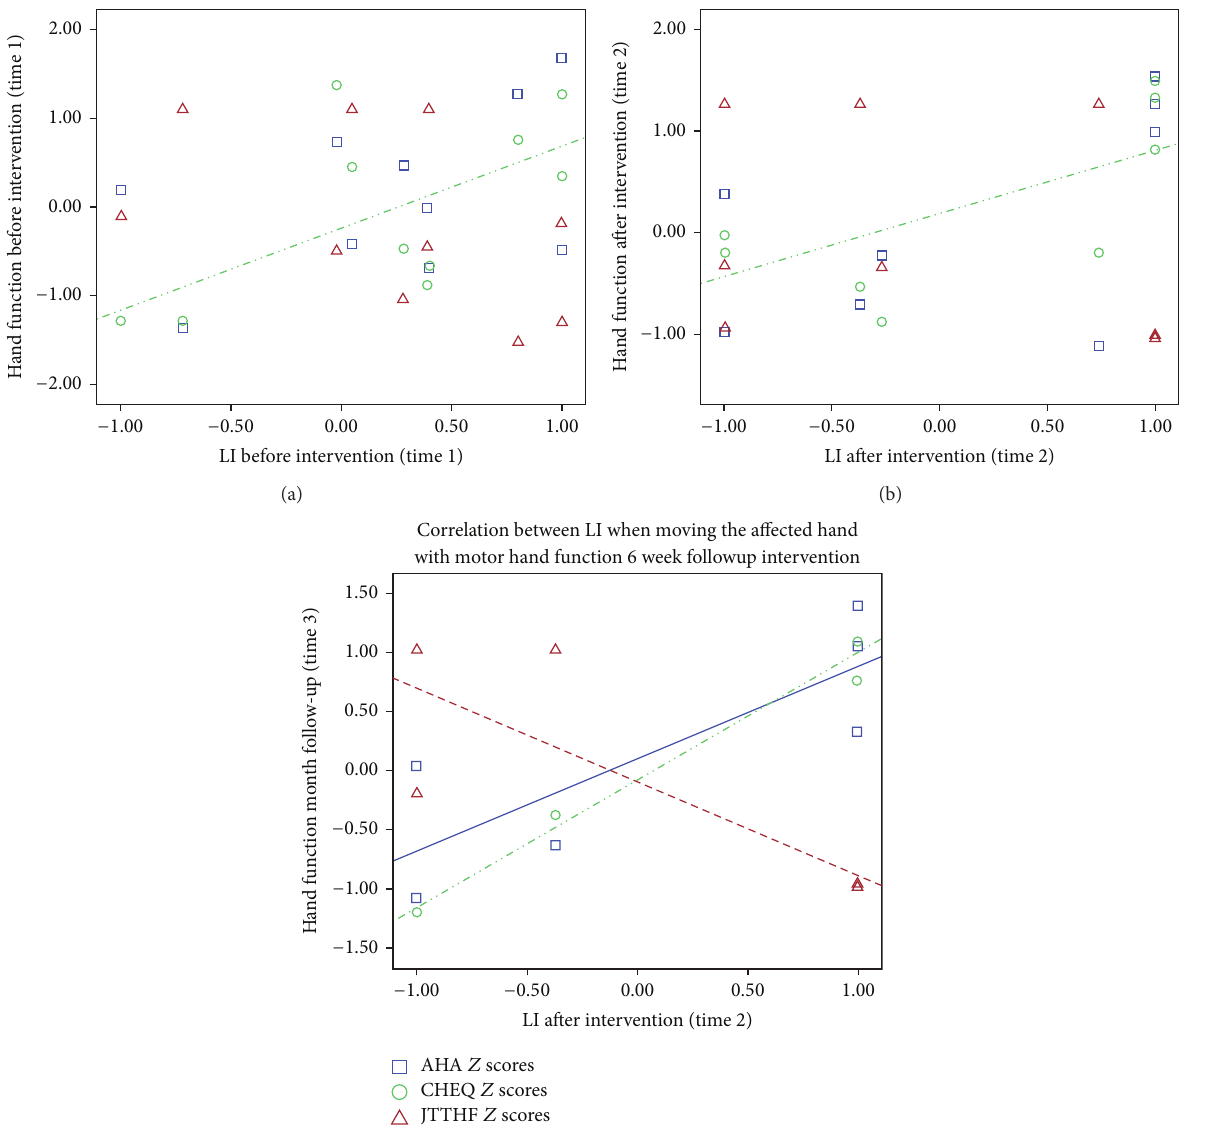
processes continued during the six weeks enabling greater efficacy in more varied